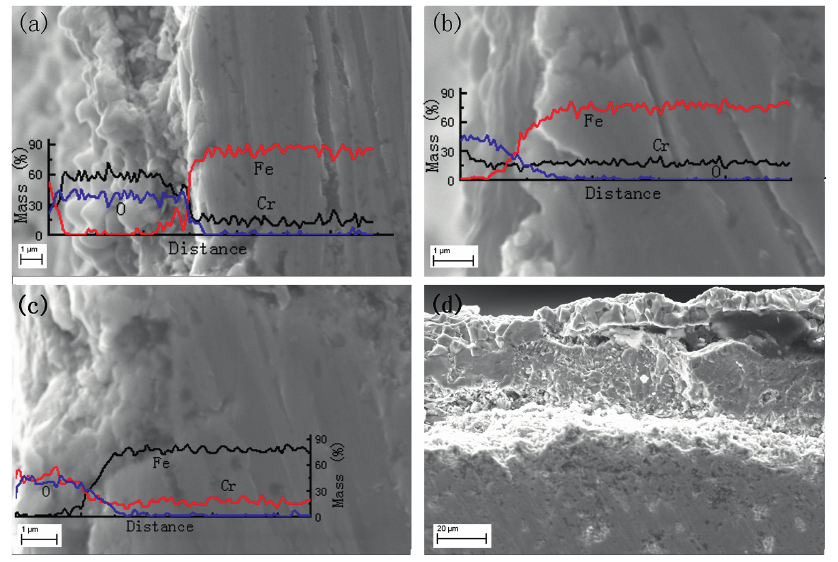
Figure 6: SEM image and element distri- bution probed by EDS for the oxidized stainless steel at 1,000°C in (a) dry air; (b) air with 3.5 vol.% H 2 O; (c) air with 11.5 vol.% H 2 O (Cr 2 O 3 based scale); (d) air with 11.5 vol.% H 2 O (Fe-rich oxi- des scale).